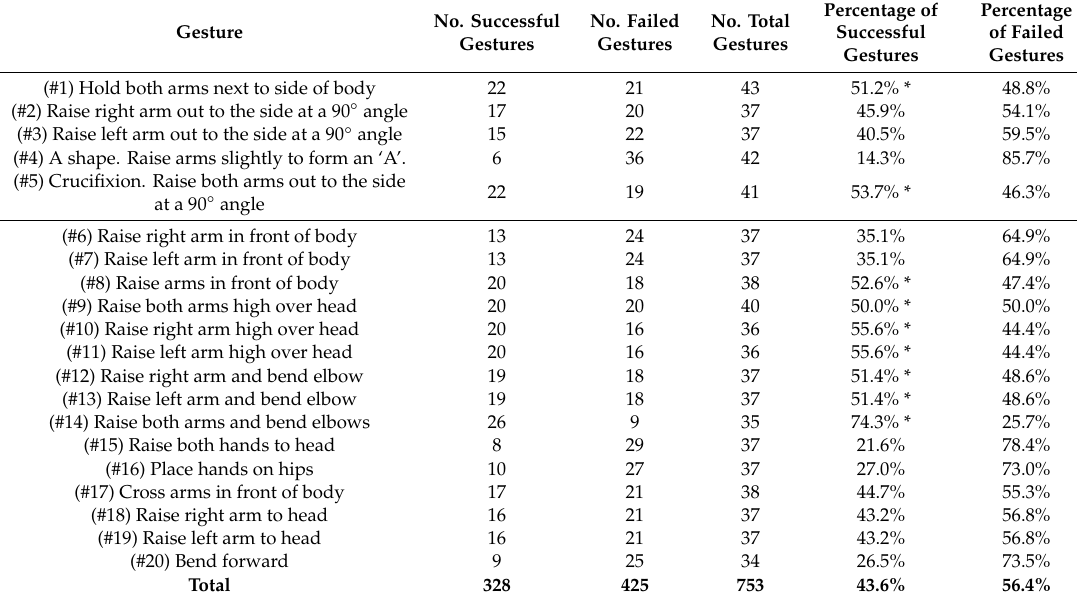
Table 3. Contingency tables for success rates of Kinect